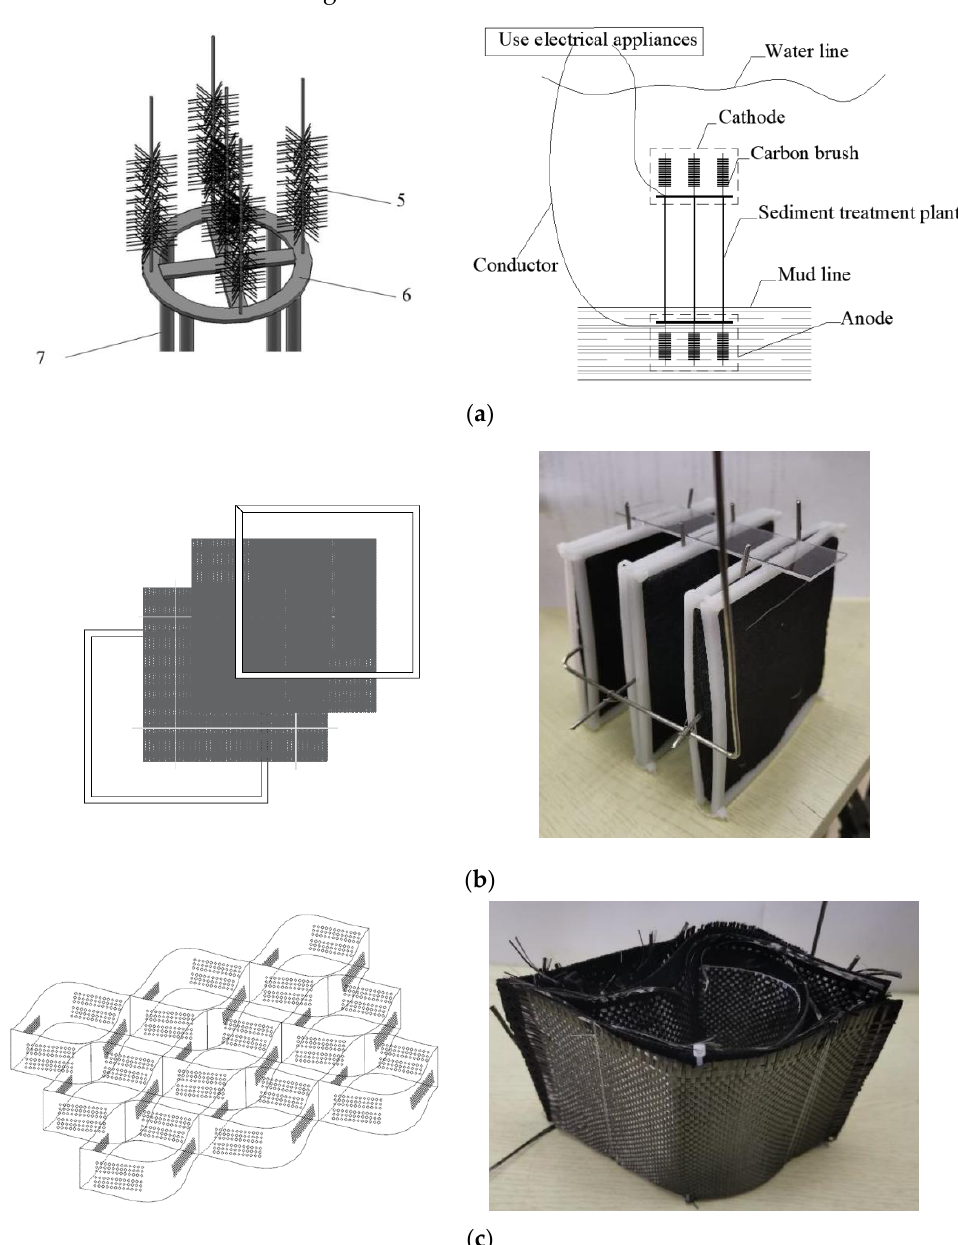
Figure 1. Schematic diagrams of the graphite felt anode. ( a ) Schematic diagram of the carbon fiber brush electrode and SMFC device; ( b ) schematic diagram of the graphite felt anode; ( c ) schematic diagram of the graphite felt anode.